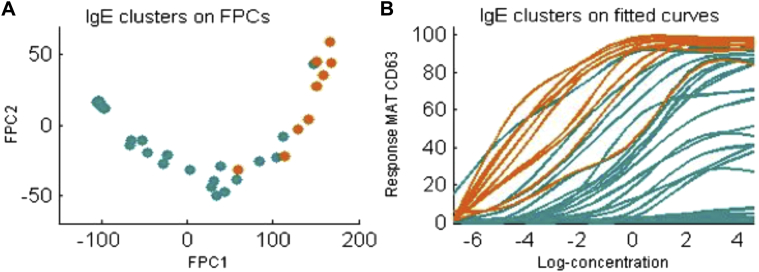
K-means clustering on sIgE data in patients with peanut allergy. A, MAT responses on the first 2 principle components, assigned to the 2 IgE clusters detected. B, IgE clusters on MAT response curves to peanut.